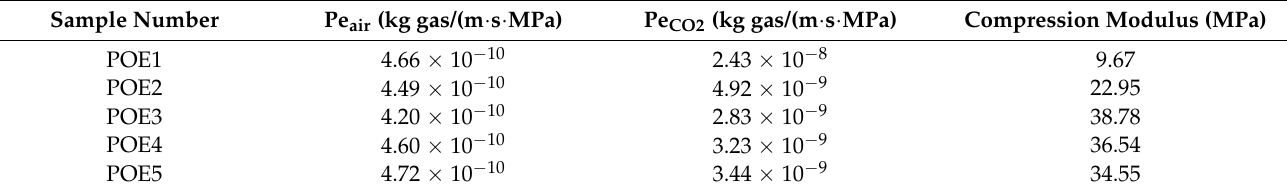
Table 5. Some parameters for dimensional stability of POE